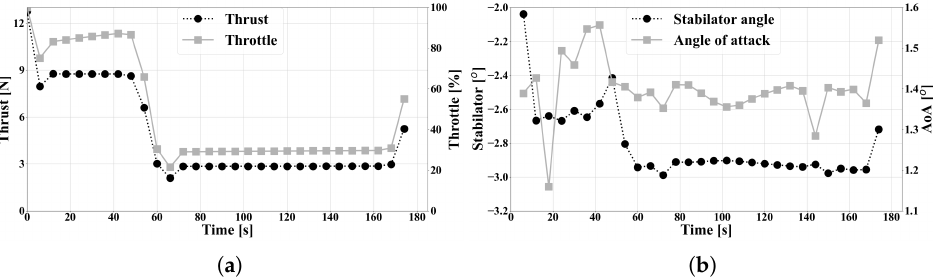
Figure 26. Optimal control: ( a ) Throttle control and thrust response; ( b ) Stabilator control and angle of